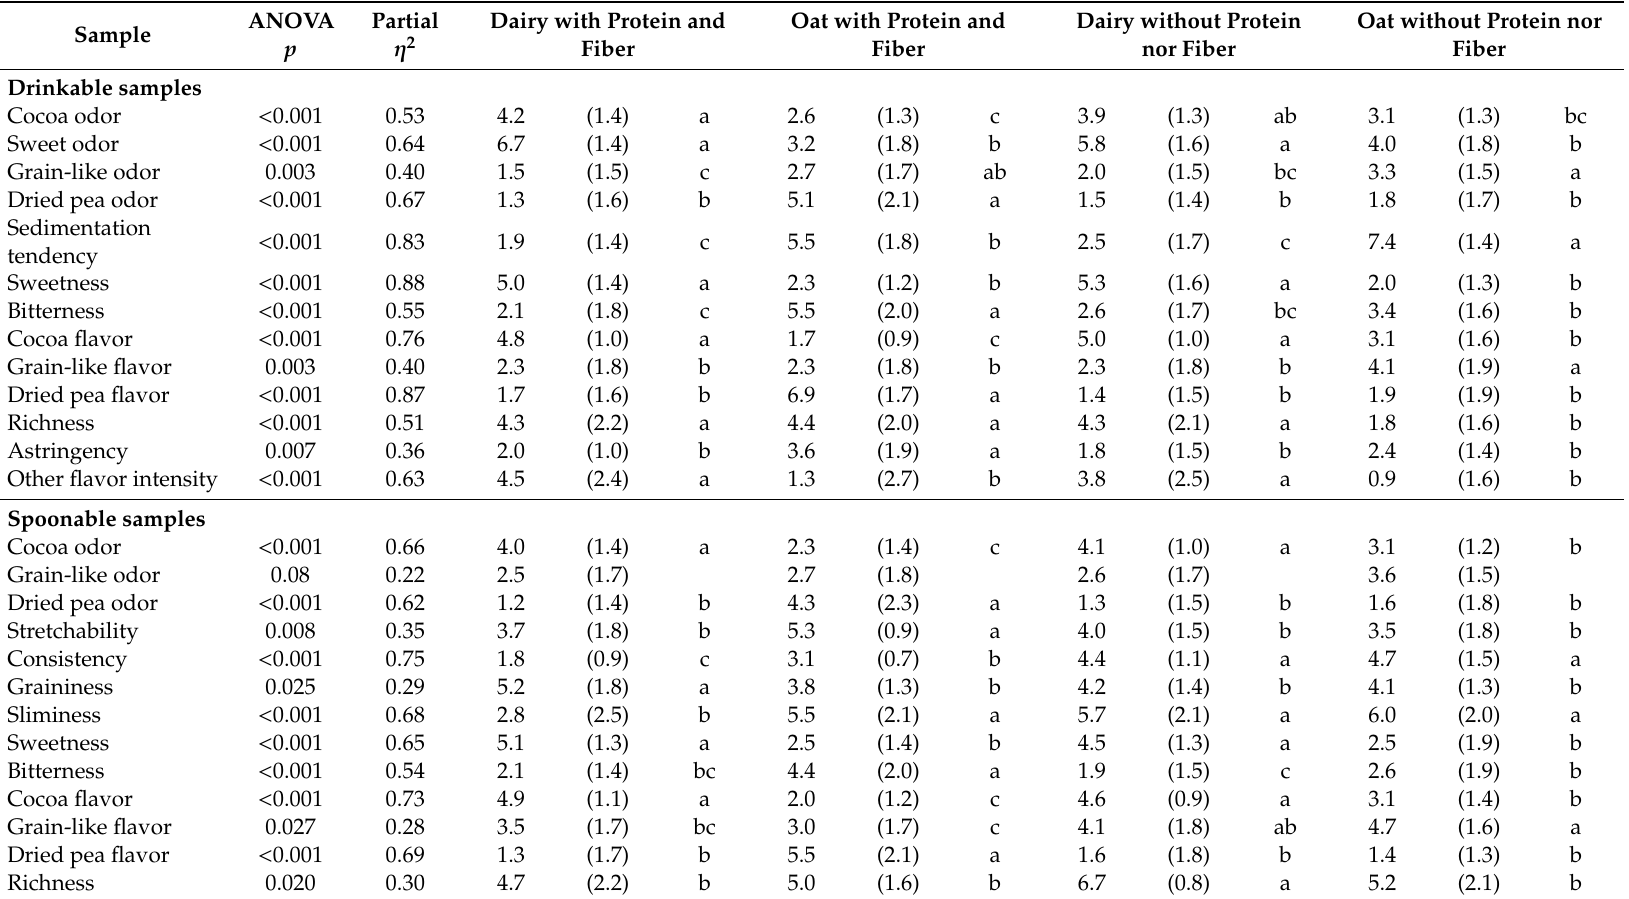
Table 3. Two-way mixed-model ANOVA results (averages and standard deviations) for the drinkable and spoonable